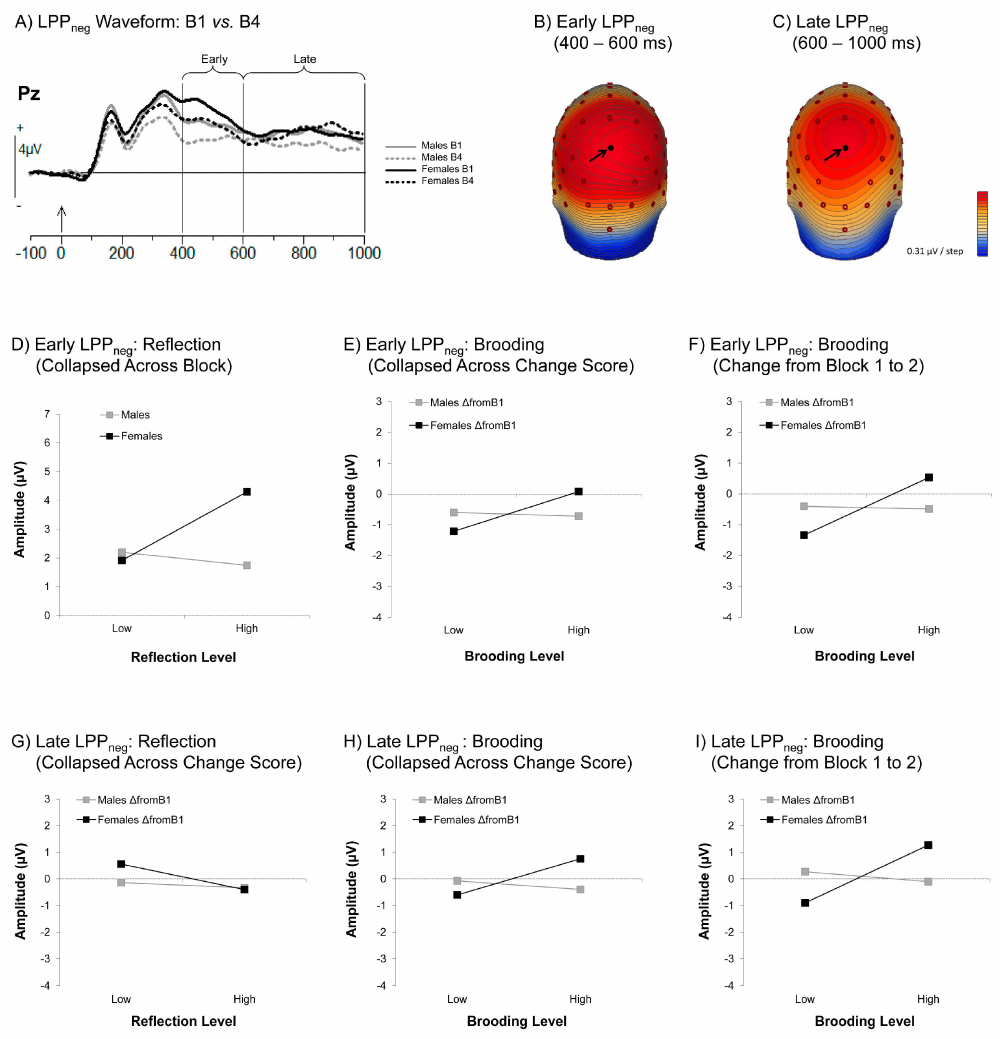
Figure 5. Late Positive Potential in response to errors ( i.e. , LPP neg ) as a function of RRS and gender. ( A ) Early (400–600 ms) and Late (600–1000 ms) LPP neg grand mean waveforms plotted at Pz for the first (B1) and last (B4) blocks. ( B , C ) Scalp distribution of the LPP neg in the early and late periods, respectively, for all subjects, collapsed across all four blocks. The arrows point to Pz, which is highlighted in black. ( D ) Effects of Reflection on early LPP neg amplitude. Effects of Brooding on change in early LPP